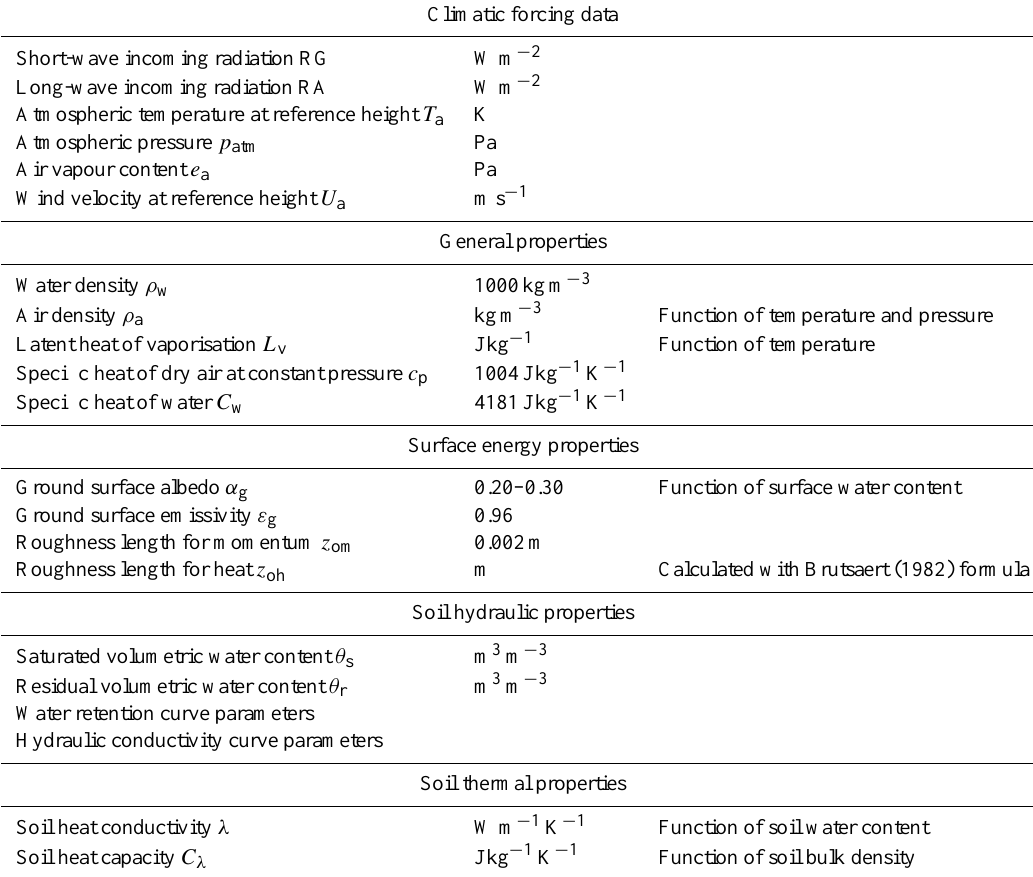
Climatic forcing